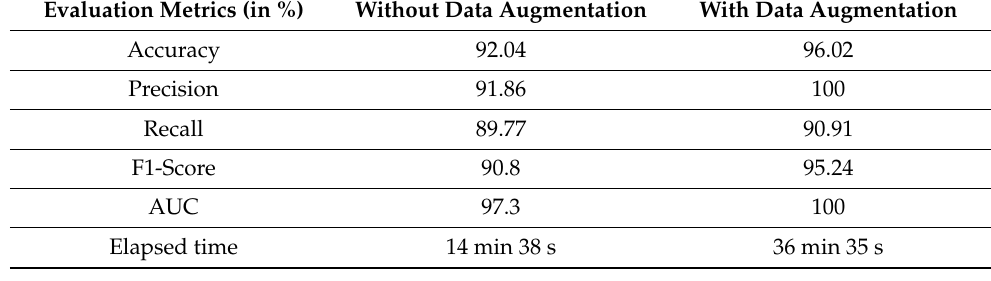
Table 8. Comparison of the best performing method with and without data augmentation. .